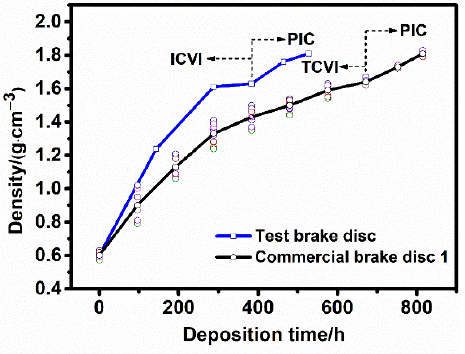
Figure 2. Variations in the densities of the test brake disc and commercial brake disc 1 over time.